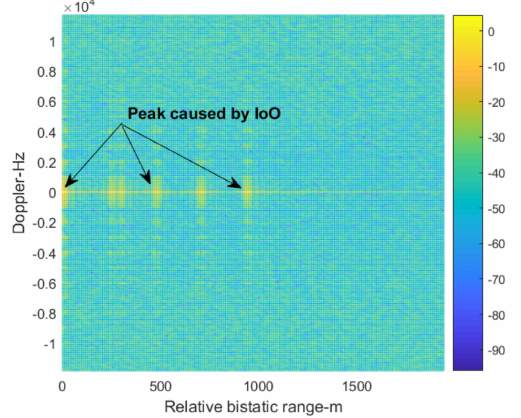
Figure 9. The cross-correlation results of the surveillance